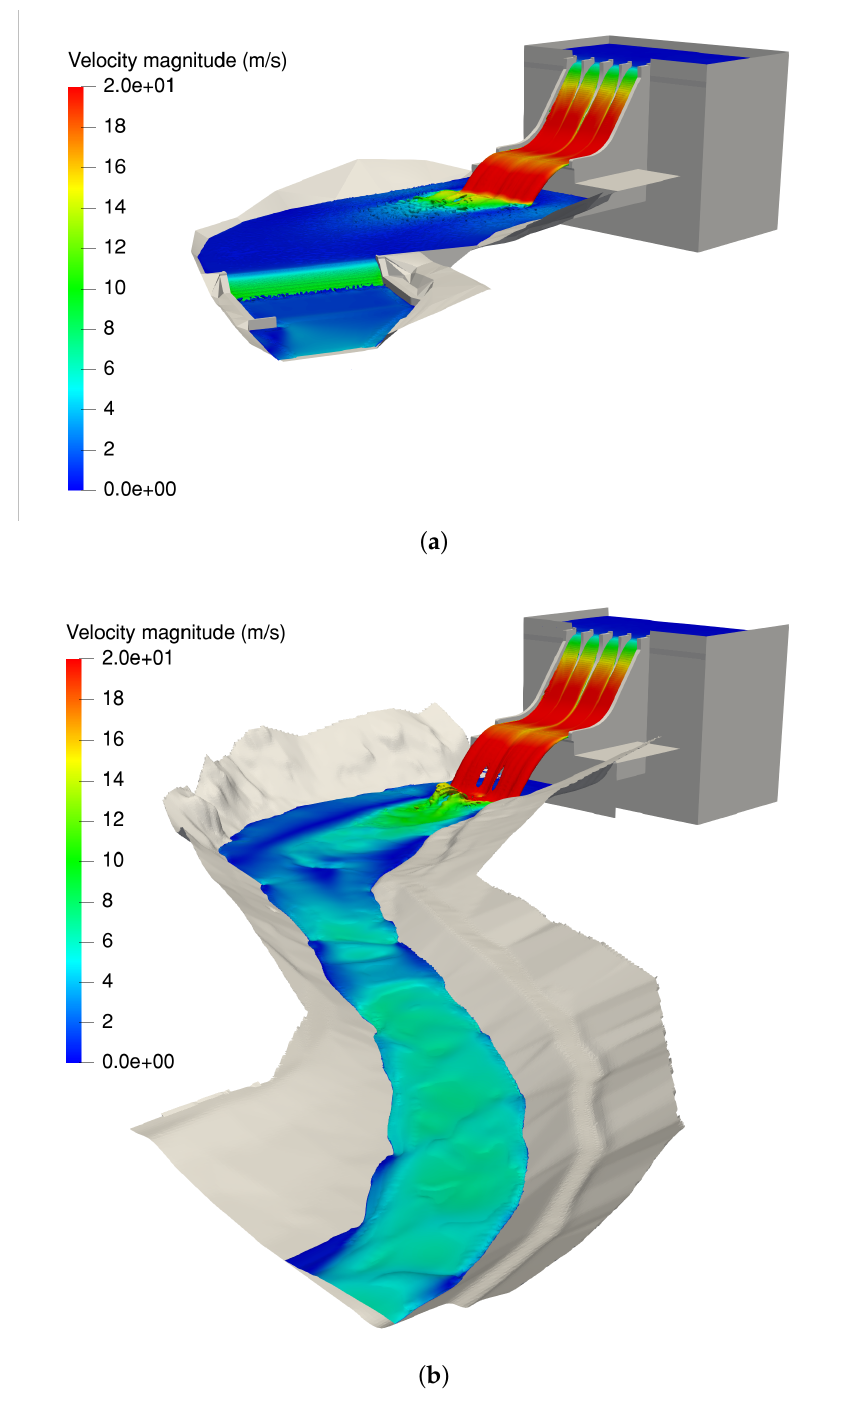
Figure 15. Free surface water structure and velocity comparison for the simulations with ( a ) and without ( b ) the secondary dam at discharge flow rate of 300 m 3 /s. Scale effects may affect reduced scale physical models simulated with Froude similarity. Specifically, aeration of the spillway jet reproduced at the model scale is less than in the prototype. The comparison of bottom mean pressures in the dissipation tank showed a good matching between numerical and physical modelling. This can be considered as an indirect proof of the correct reproduction of the spillway impact with the validation case. However, due to the scaling